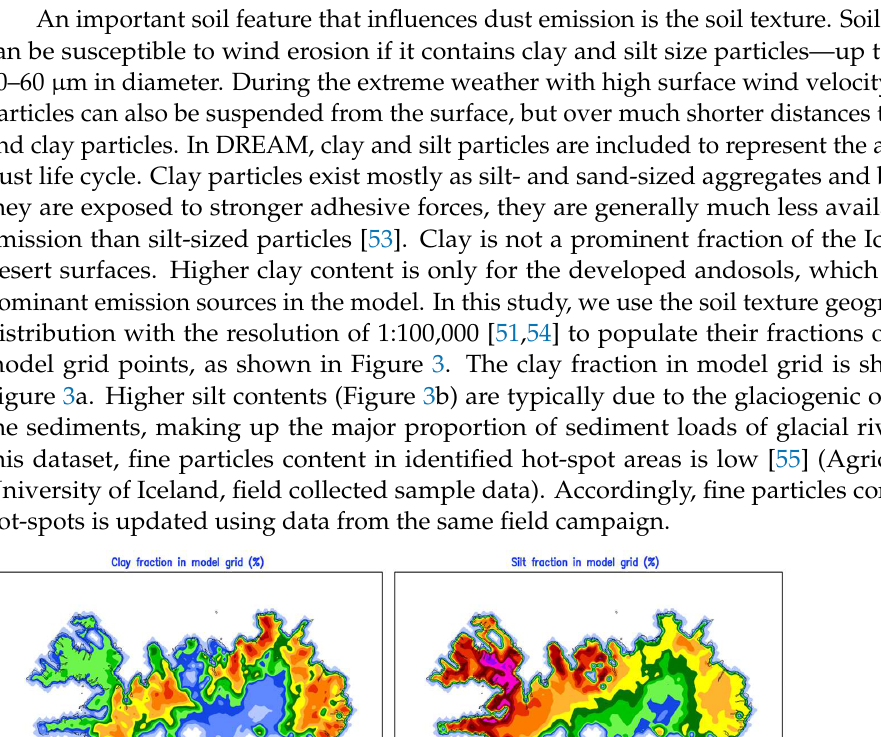
Figure 2. Derived dust source mask for Iceland as seen on the model horizontal resolution of 0.05 degrees.